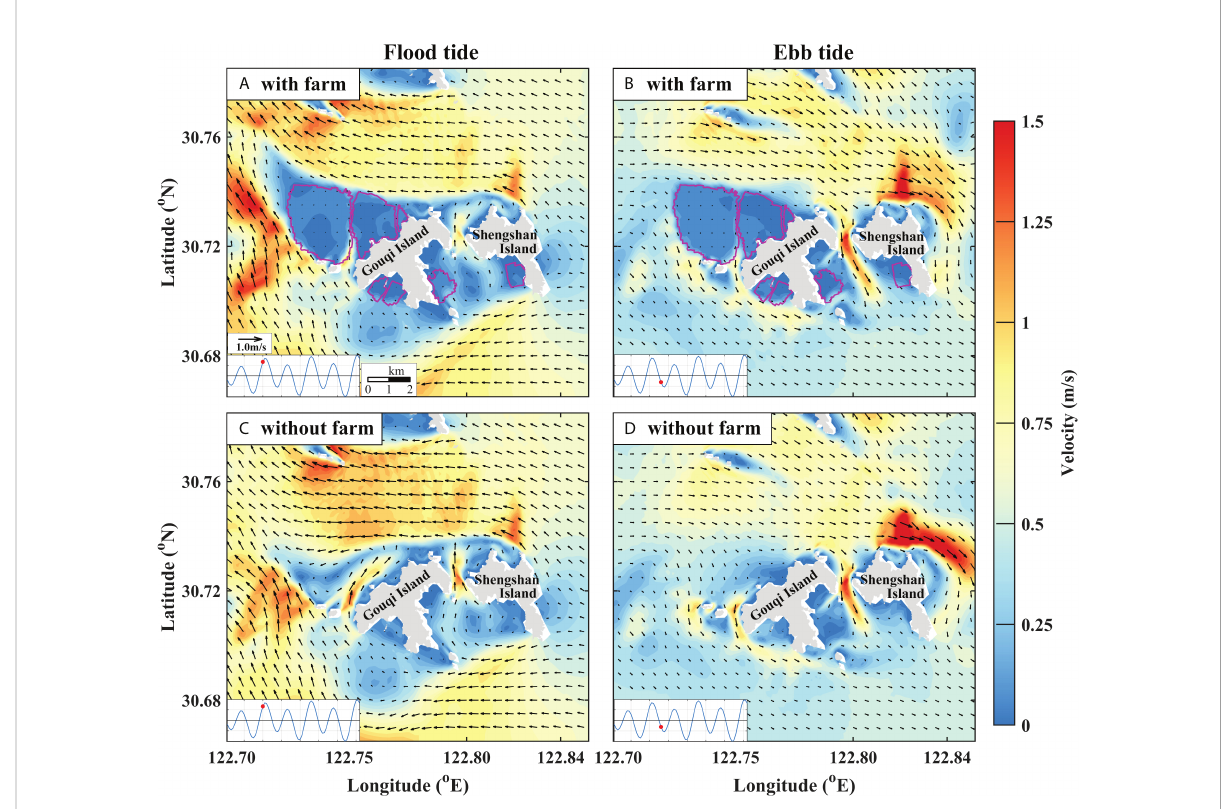
FIGURE 8 Predicted instantaneous surface layer (depth=0.1d, where d is local depth) fl ow fi eld. (A, B) with and (C, D) without mussel farms during fl ood (Left) and ebb (Right) tide. The pink lines indicate the borderlines of the farm. The insert plot is the time series of the observed tidal elevation at Shengshan Tide station (122°28 ′ E,30°43 ′ N) with the red dot indicates the time instant of tidal elevation shown in the